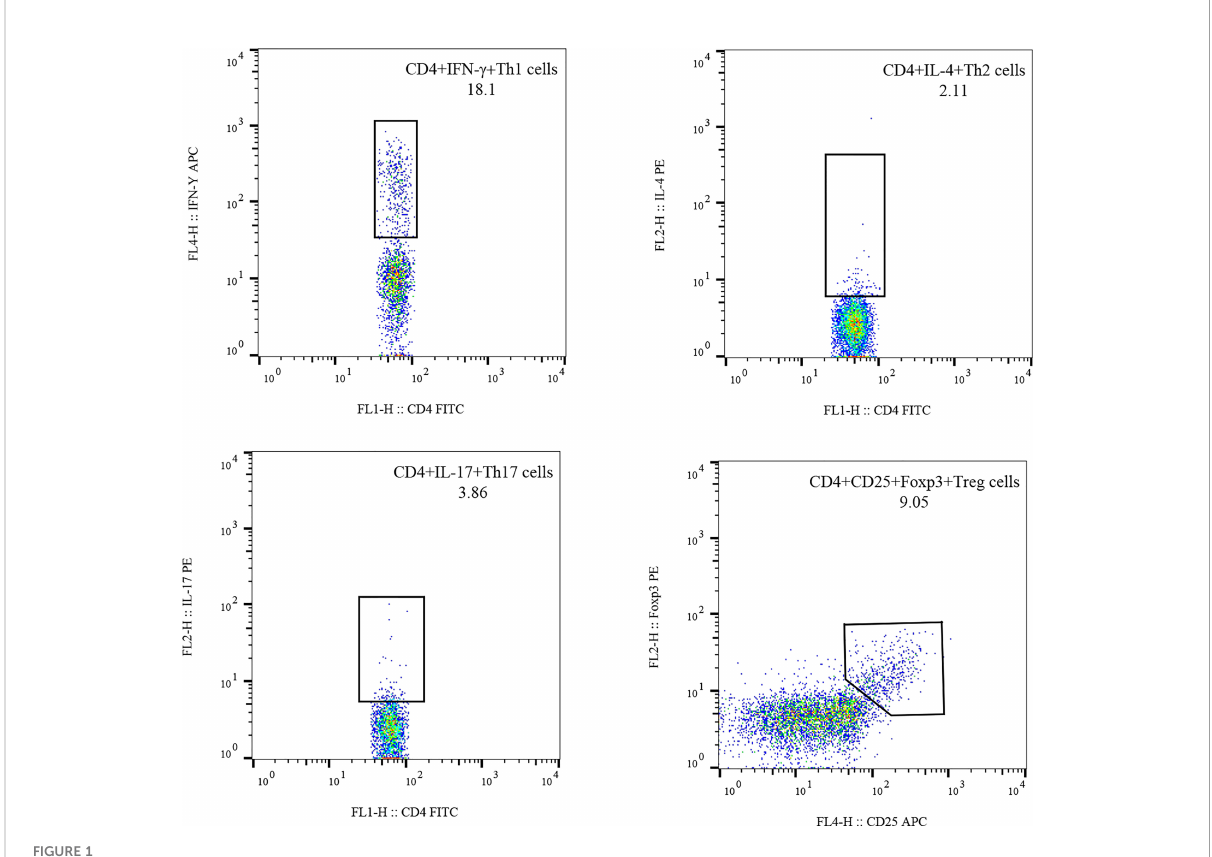
FIGURE 1 Gating for Th1,Th2,Th17 and Treg